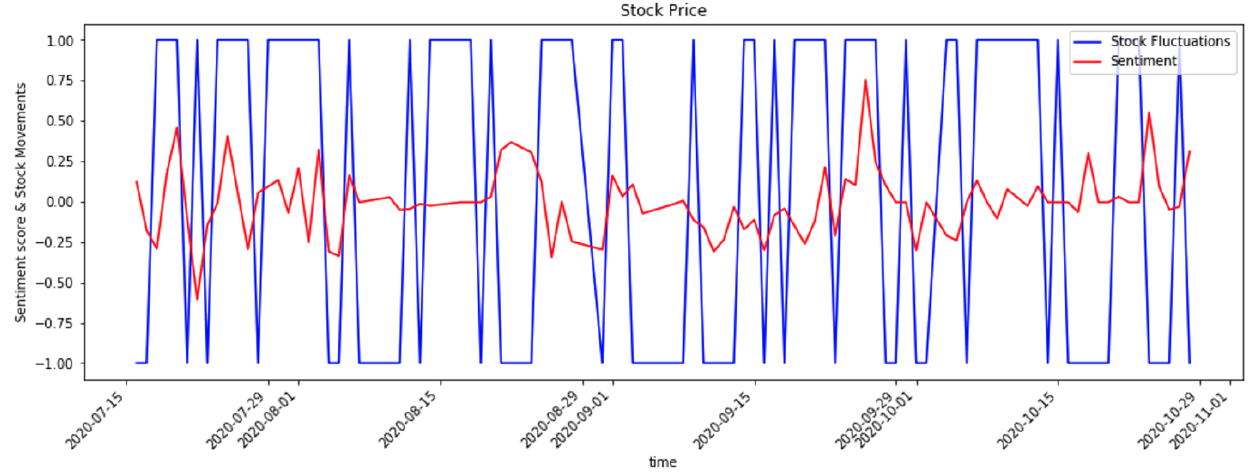
Figure 6. Sentiment and stock change for ‘StockTwits with VADER’ data